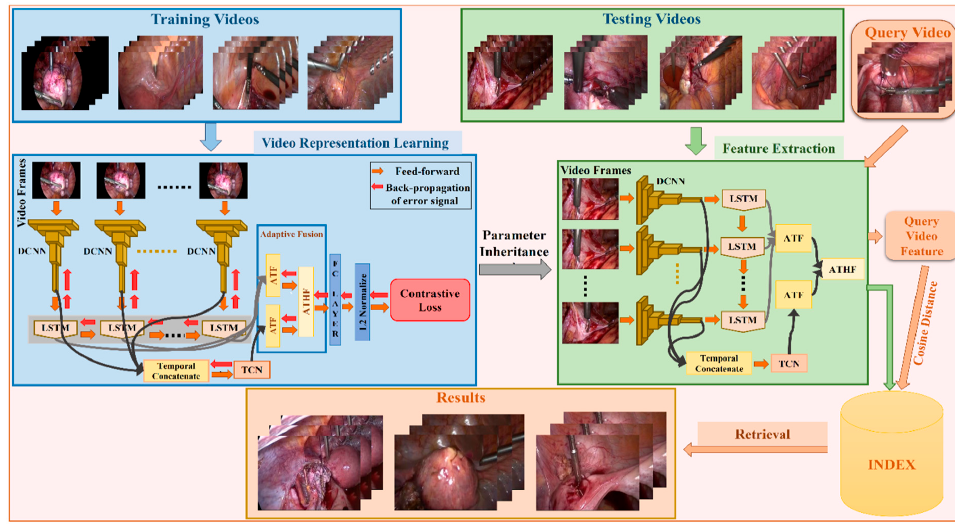
Figure 3. Overview of the proposed CB ‐ SVR system.